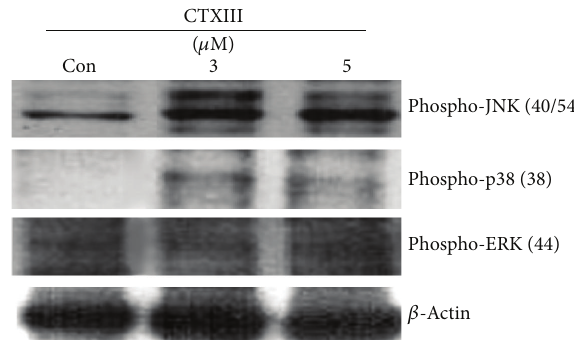
Figure 4: The regulation of MAPK signaling by CTXIII. Ca9-22 cells were treated with vehicle control, 3 and 5 𝜇 g/mL of CTXIII for 24 h, respectively. The phosphorylation levels of three major MAPK members JNK, p38, and ERK were examined using the Western blot assay. 𝛽 -Actin was used as an internal control. Each representative blot was performed in at least